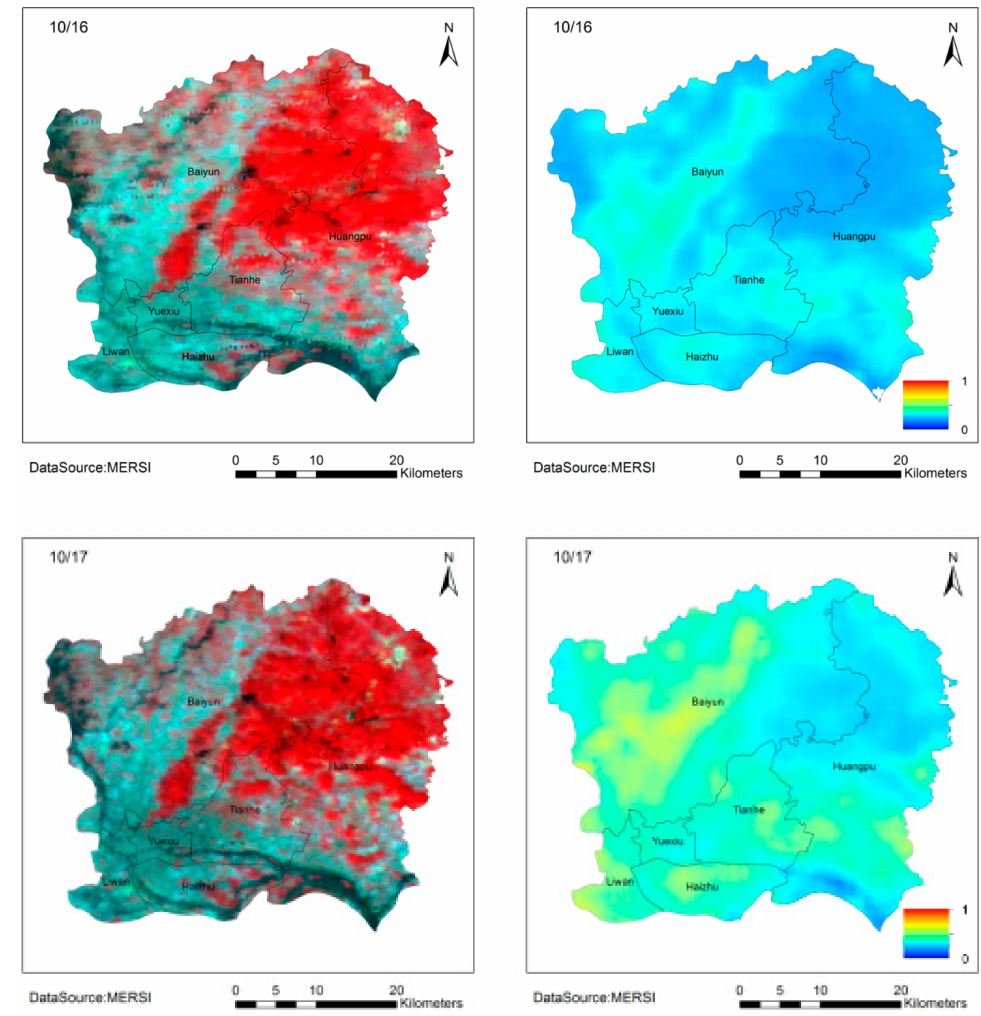
Figure 11. False-color (left) and AOD (right) images on 14–17 October